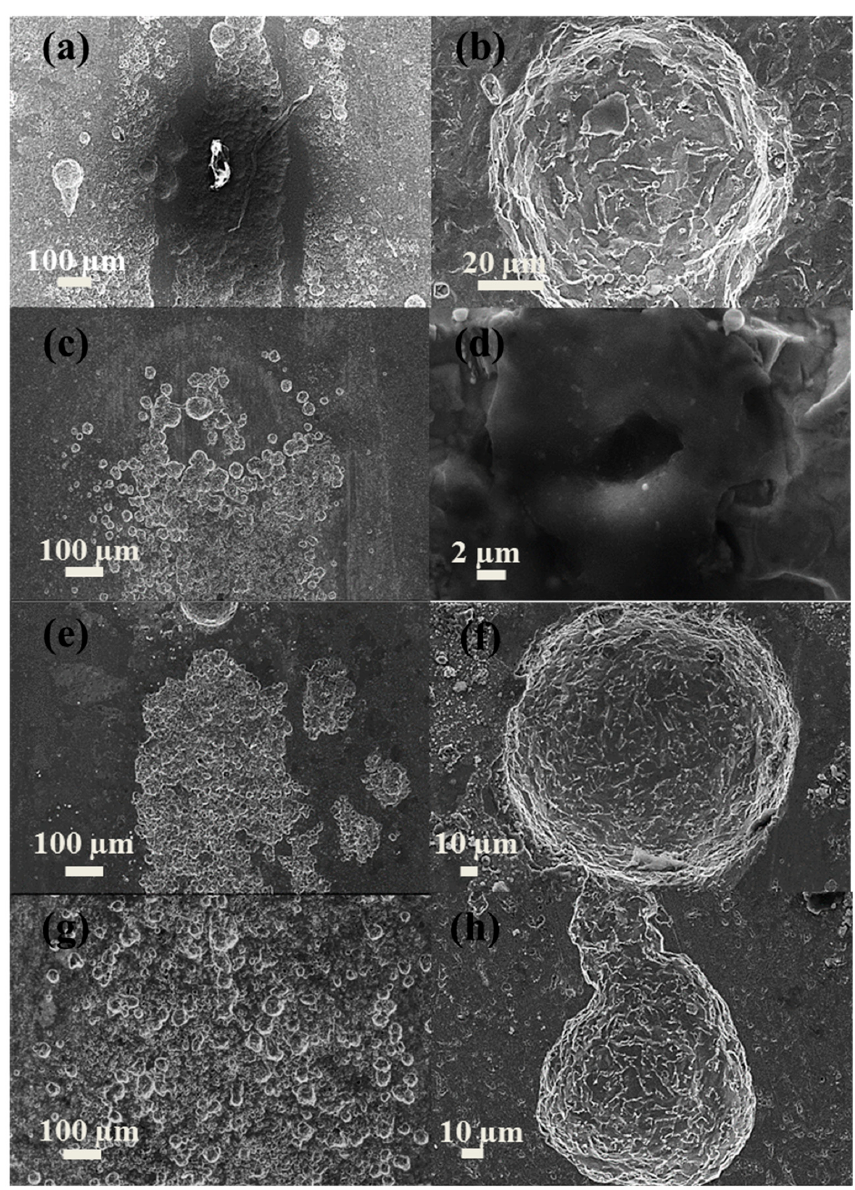
Figure 4. SEM morphologies of Q235 carbon steel after immersion for 86,400 s in 2000 mg/L NaHCO 3 and NaCl concentration of: ( a ) and ( b ) 500 mg/L NaCl, ( c ) and ( d ) 800 mg/L NaCl, ( e ) and ( f ) 1000 mg/L NaCl, ( g ) and ( h ) 1200 mg/L NaCl, loosened corrosion products were removed.